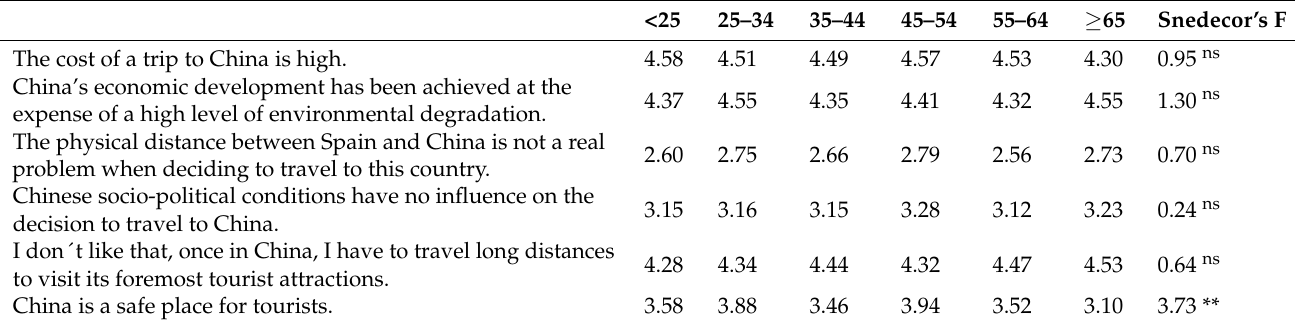
Table A4. Factors inhibiting visits to China (differences by